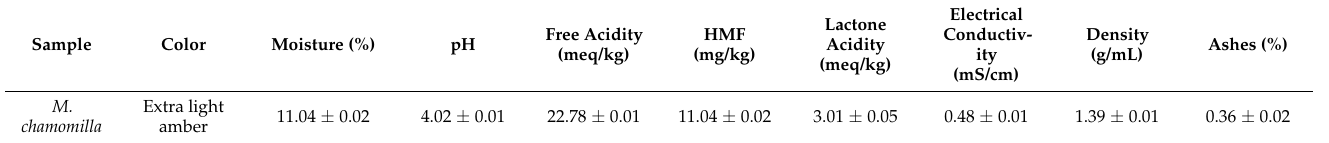
Table 1. Physicochemical characteristics of M. chamomilla honey